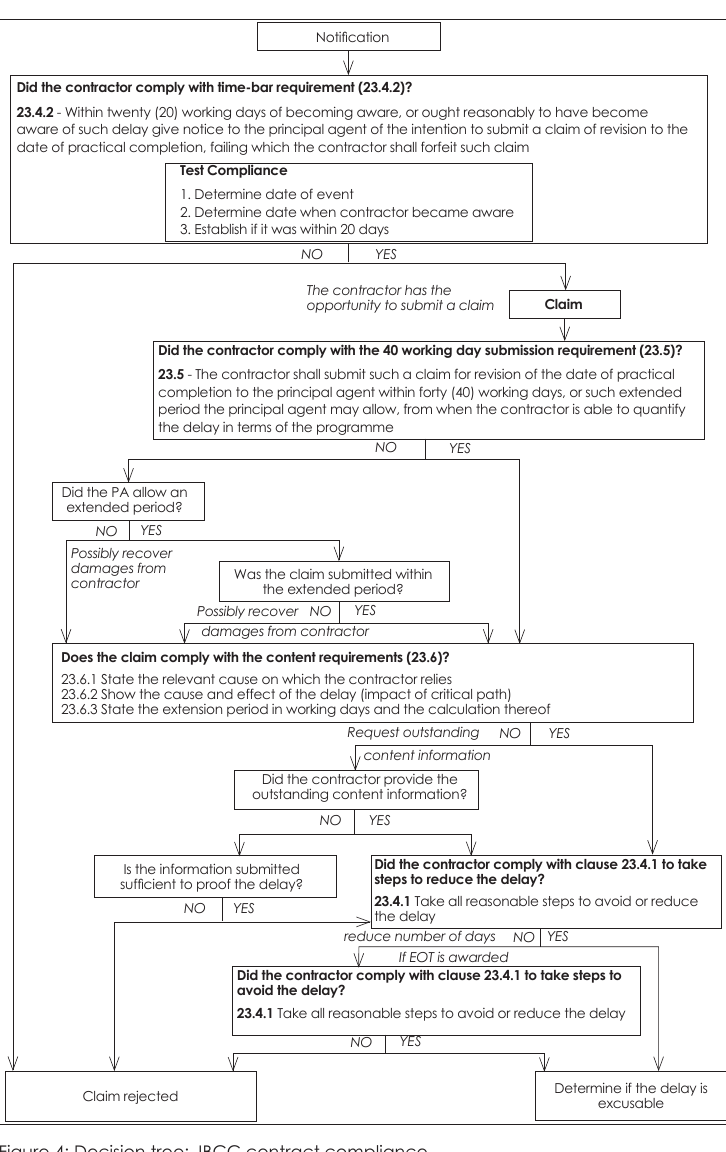
Figure 4: Decision tree: JBCC contract